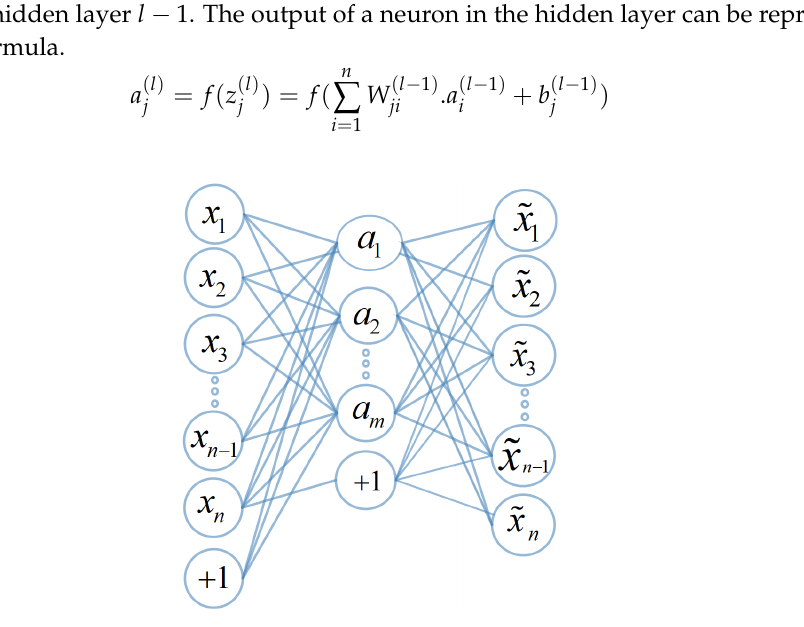
Figure 2. The structure of an